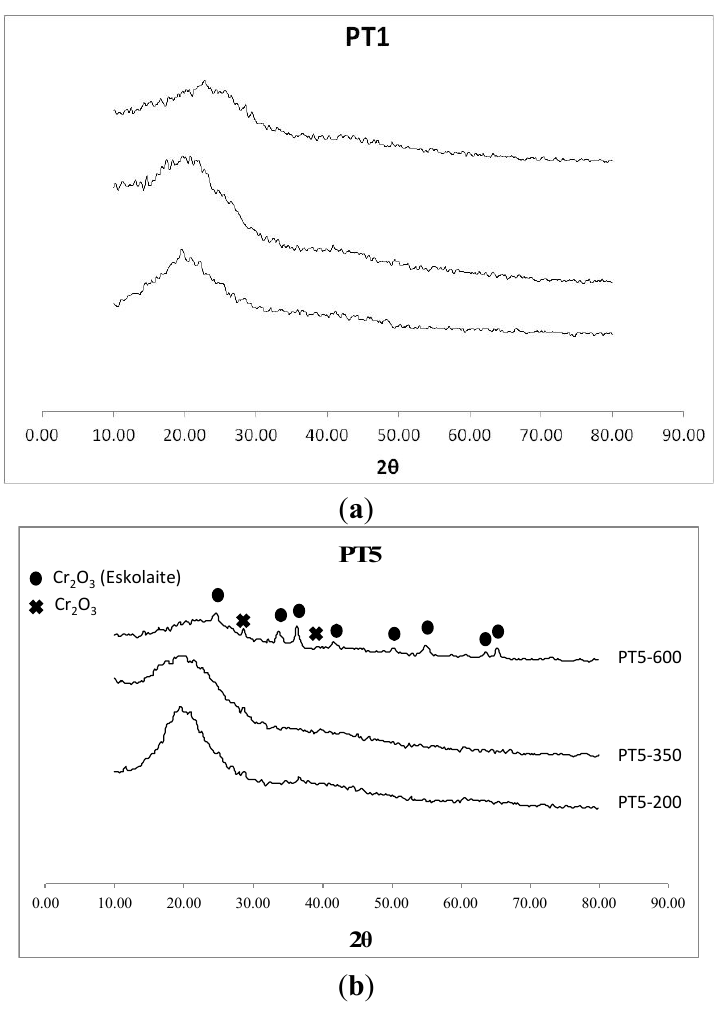
Figure 2. X-Ray diffraction (XRD) patterns of PT1 and PT5 carbonized under nitrogen at 200, 350 and 600